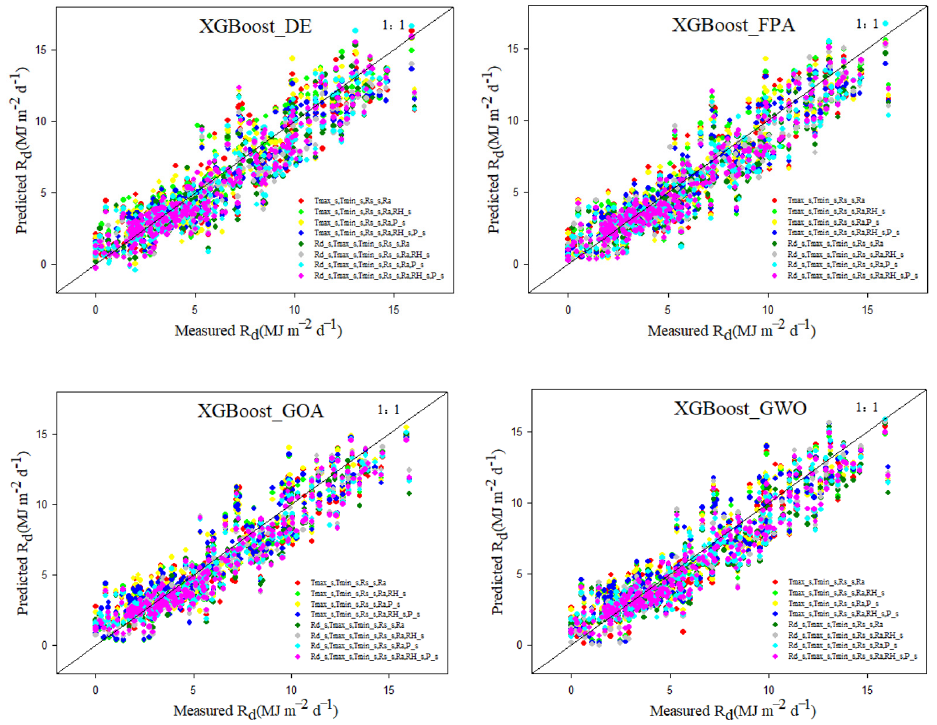
Figure 2. Scatter plots of R d predicted by the coupling models based on Himawari-7 data in Figure 2. Sca tt er plots of R d predicted by the coupling models based on Himawari-7 data in Bei- jing.